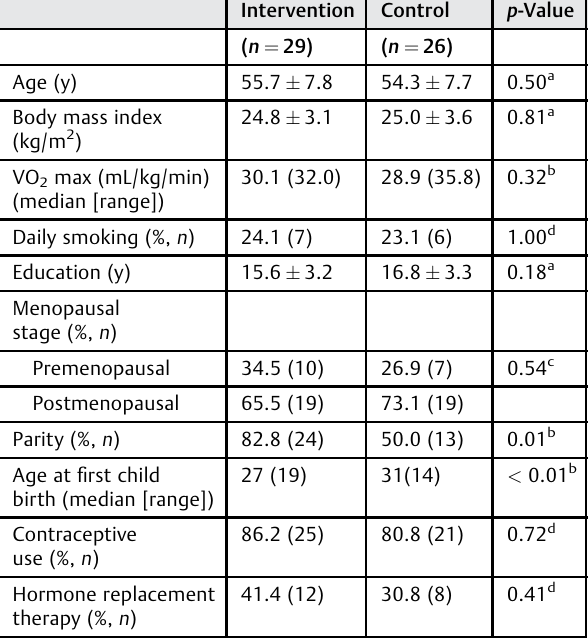
Table 1 Patient characteristics at baseline Table 2 Tumor characteristics